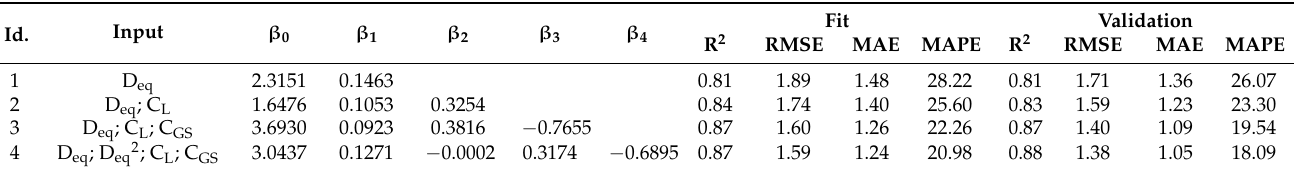
Table 4. Regression coefficients and model performance criteria used to predict crown